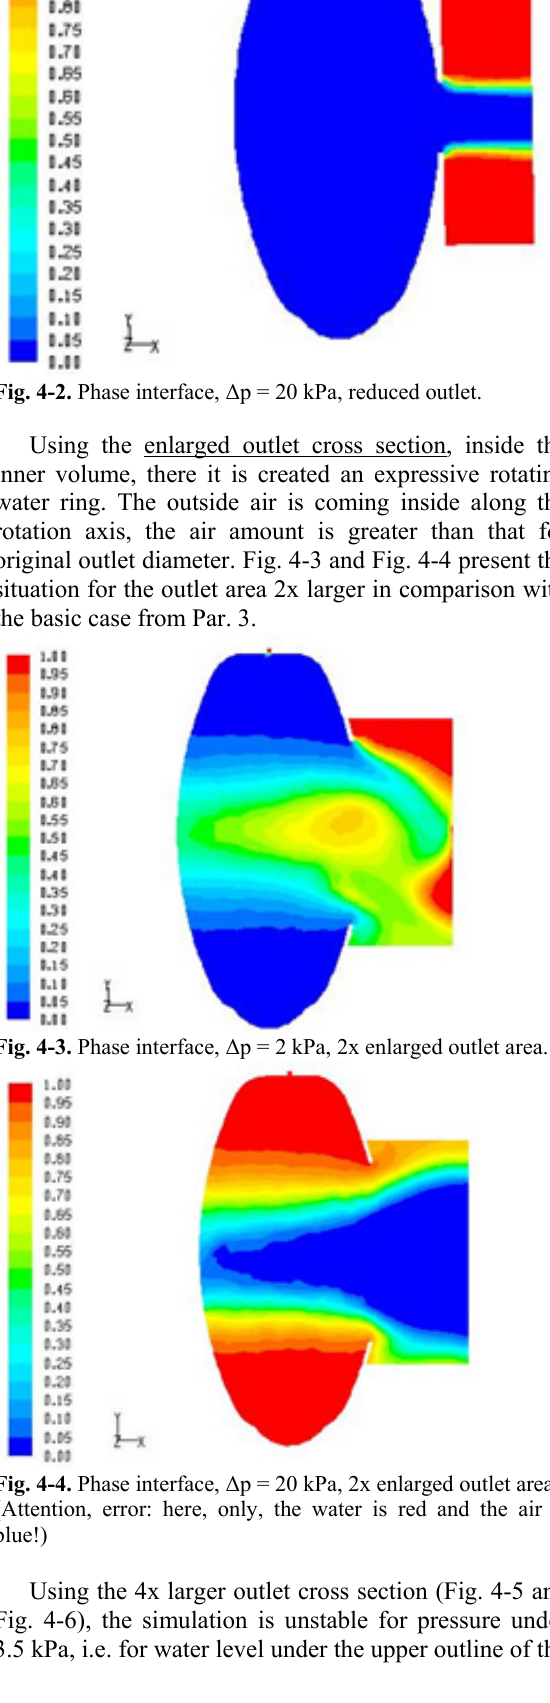
Fig. 4-7. Summary characteristics – changes of the outlet